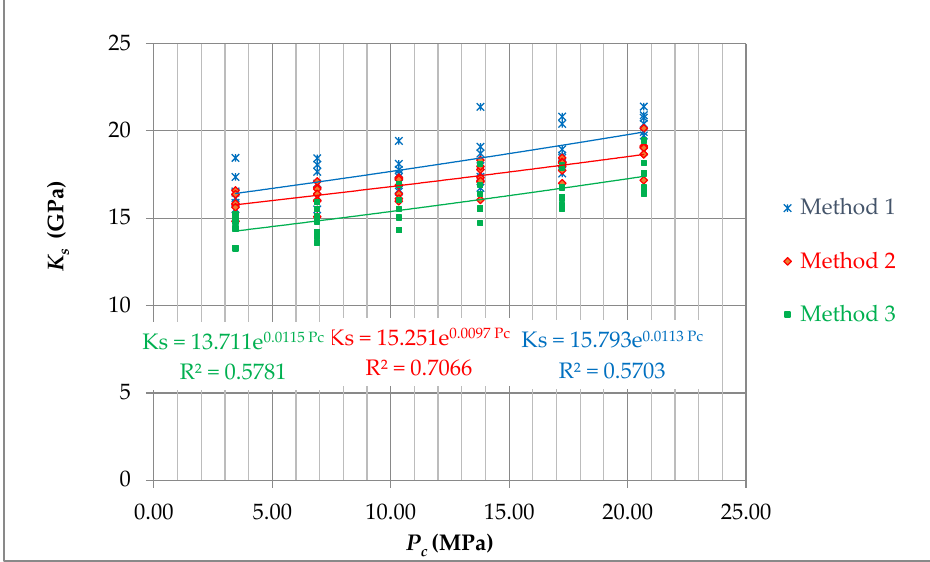
Figure 8. Calculated values of 𝐾 𝑠 as a function of the hydrostatic stress for the three methods.